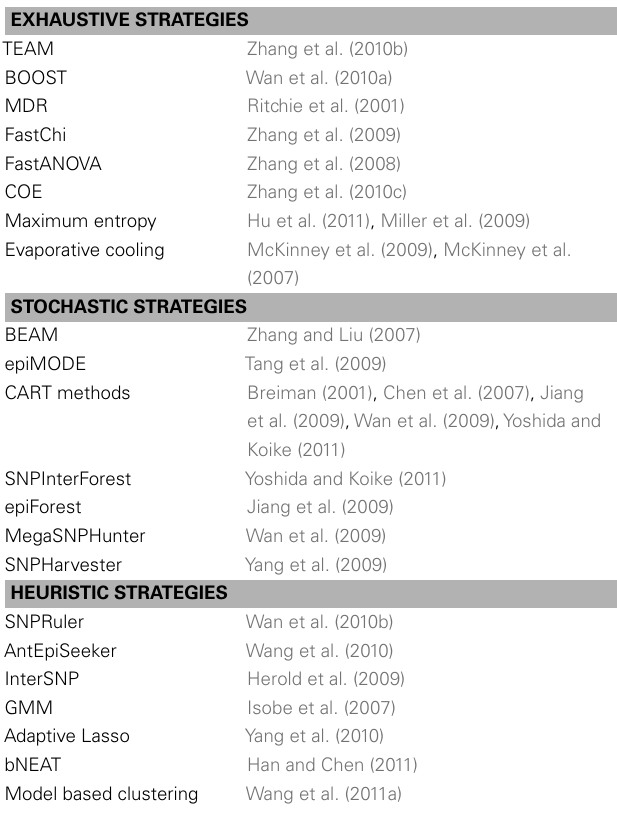
Table 1 | Collection of exhaustive, stochastic and heuristic methods for the detection of epistatic interactions in case/control studies or organismal QTL level